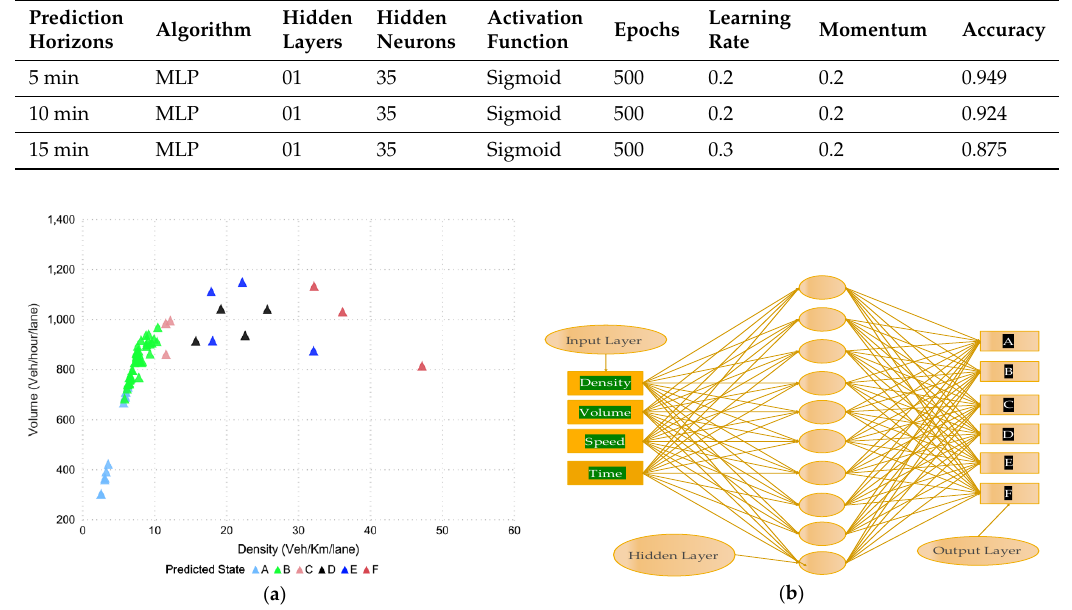
Figure 11. MLP model. ( a ) Predicted state for next 15 min horizon. ( b ) MLP network with 01 hidden layer.